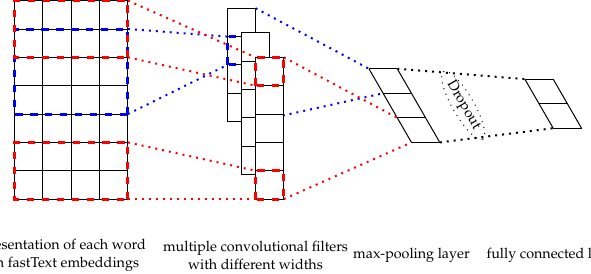
Figure 2. The architecture of the convolutional